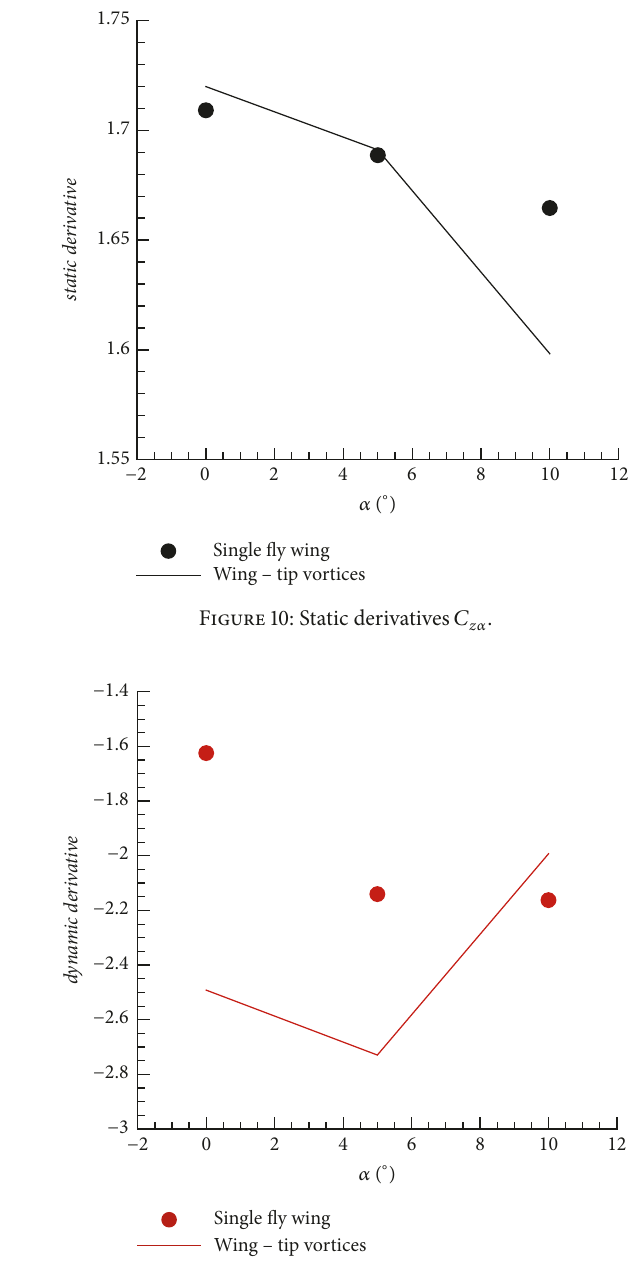
Figure 11: Dynamic derivatives 𝐶 𝑚 ̇𝛼 + 𝐶 𝑚𝑞